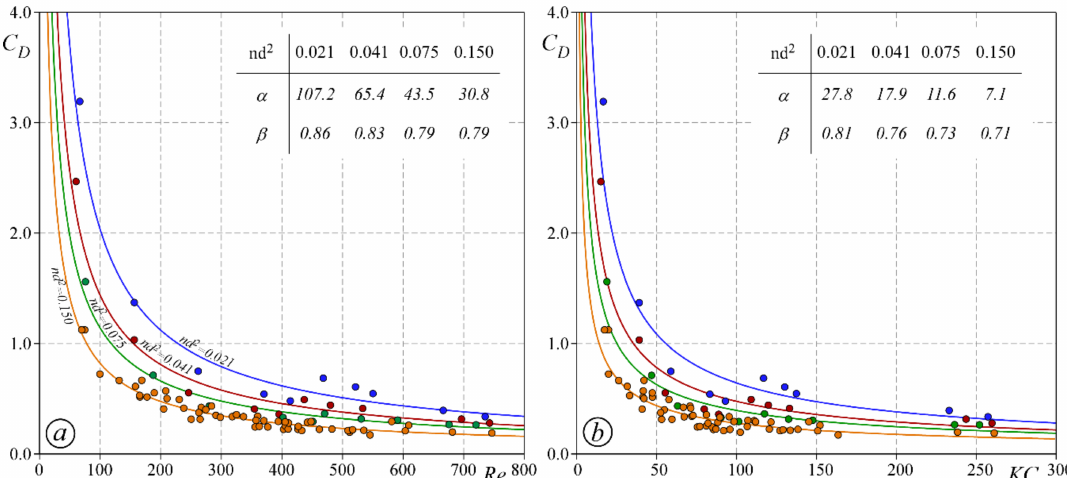
Figure 8. Predicted drag coefficient, C D , versus Reynolds number, Re , (panel ( a )) and Keulegan–Carpenter number, KC , (panel ( b )) for the four stem densities. The table in the insets gives the coefficients α and β to be used in Equation (10).